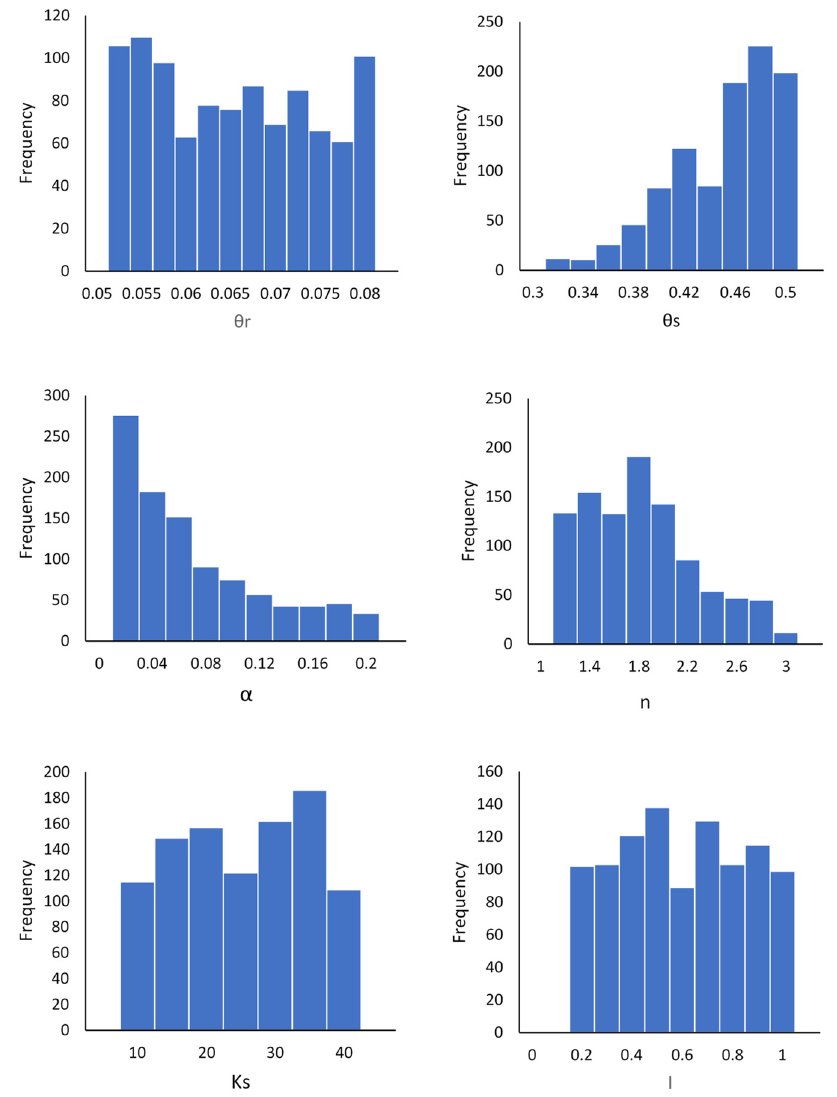
Figure 2. Posterior distributions of the water flow simulation parameters.